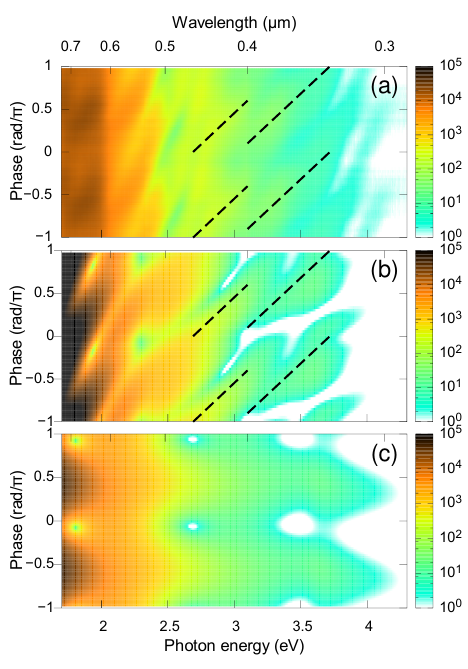
Figure 3. CEP dependence of the HH spectrum. (a) Experimental result. (b) Numerical simula- tion result obtained from optical Bloch equations. (c) Simulation result with the transform-limited